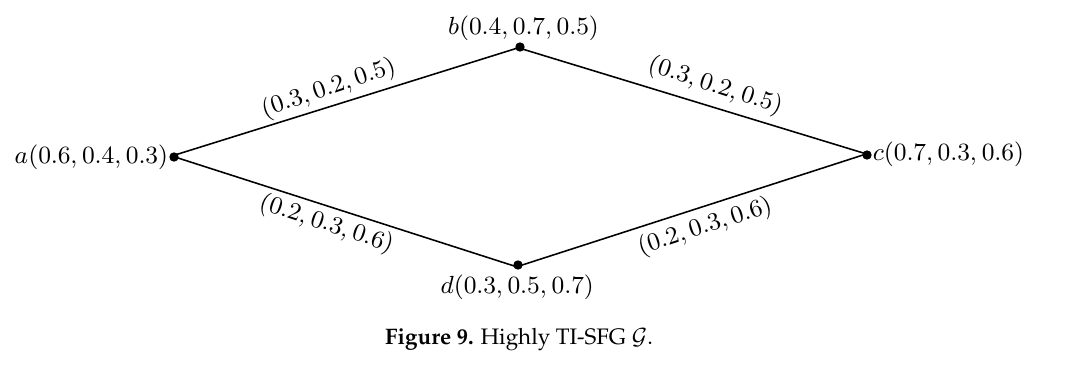
Figure 9. Highly TI-SFG G . Figure 9: Highly TI-SFG G